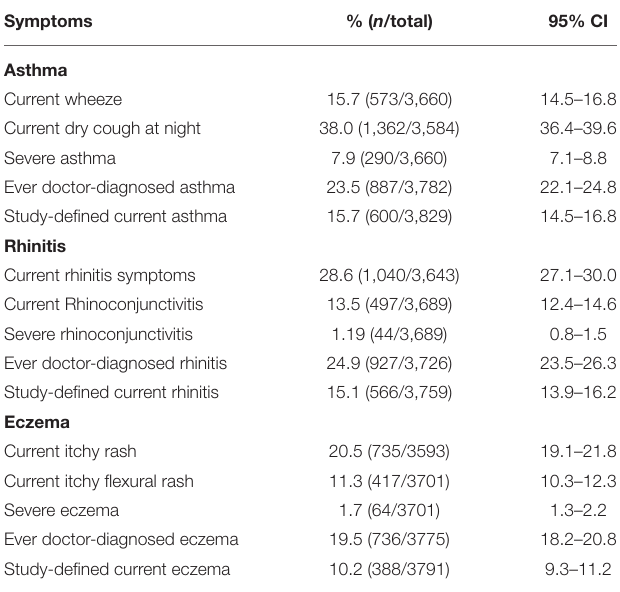
TABLE 2 | Prevalence estimates of asthma, rhinitis, and eczema symptoms.